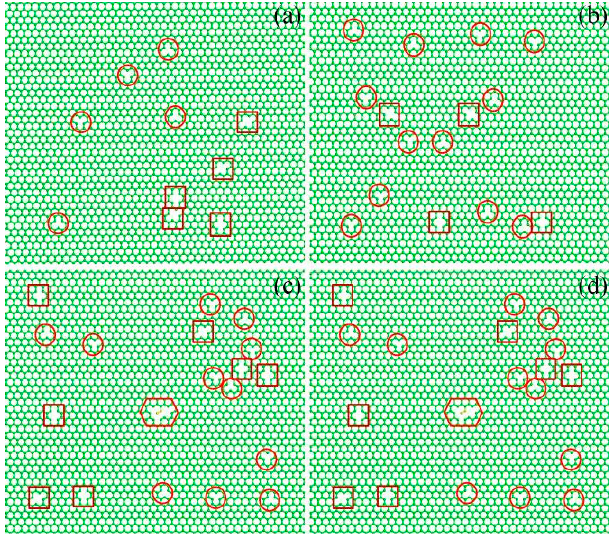
Figure 1. Configuration of graphene irradiated by a different number of incident carbon atoms (circular represents single vacancy (SV), square represents double vacancy (DV), and hexagon represents complex defects (CD)). ( a ) ion dose: 10 (SV: 5; DV: 5), ( b ) ion dose: 20 (SV: 12; DV: 4), ( c ) ion dose: 30 (SV: 11; DV: 7; CD: 1), and ( d ) ion dose: 40 (SV: 19; DV: 10; CD: 2).